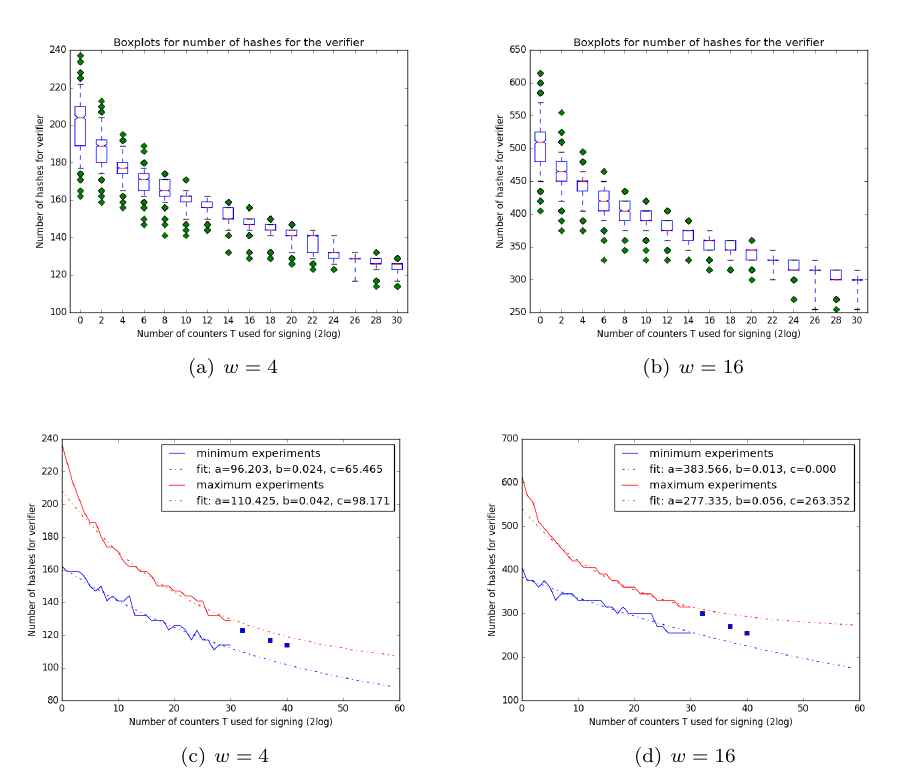
Figure 6.2: Number of hashes for the verifier in the ‘ chains, after taking the highest cumulative hash chain value out of 2 t appended counters. Top : Boxplot over 10 3 trials for each value of t . The box represents the 50% confidence interval (i.e. datapoints between the first and third quartile), with the yellow line the median. The whiskers of the boxplot represent the 95% confidence interval. The dots represent the outliers. Bottom : Blue resp. red line: minimum resp. maximum cumulative hash chain value over 10 3 experiments for each value of t . Blue resp. red dash-dotted line: extrapolated fit of a · exp( − bx ) + c over the experimental data for the minimum resp. maximum. Green dots represent three single experiments for t ∈ { 33 , 37 , 40 }